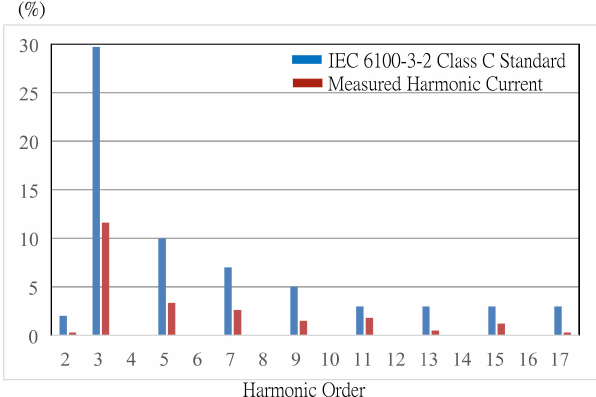
Figure 11. Harmonic spectrum of the input line